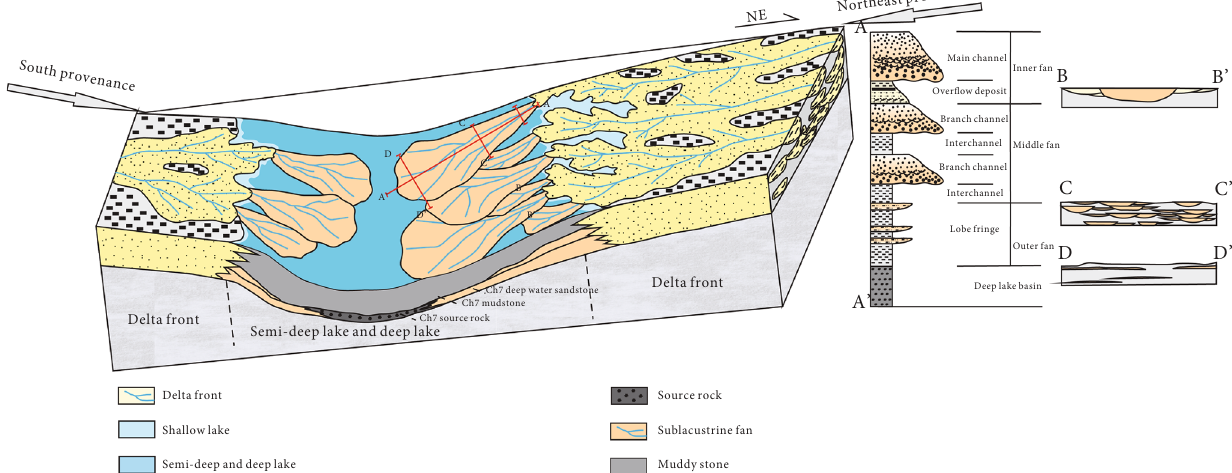
Figure 11: Depositional model of deep-water depositional systems in the Upper Triassic, southwestern Ordos Basin, and vertical sequence of all the three sedimentary